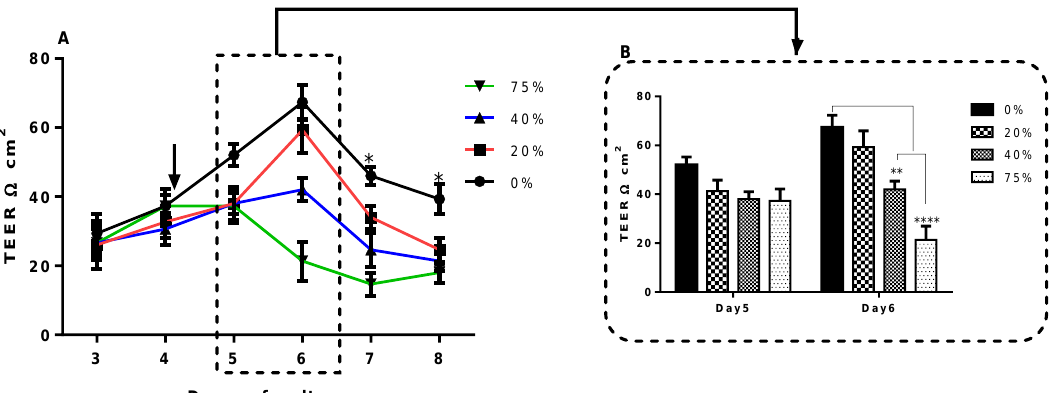
Figure 7. TEER of bEnd.3 cells exposed to selected concentrations of U-87CM. ( A ) TEER of bEnd.3 monolayer exposed to U-87CM produced from U-87 cells in normoxic conditions (21% O 2 ). The arrow indicates the start of monolayer treatment with U-87CM at the end of day 4. The asterisks (*) refer to the significant difference between controls (0%) and cells exposed to selected concentration of normoxic U-87CM; on day 7 (at 40% and 75%; * p < 0.05, *** p < 0.001, respectively); on day 8 (at 20% (* p < 0.05), at 40%, and 75% (*** p < 0.001)). ( B ) Compares “peak” TEER values across bEnd.3 monolayers on days 5 and 6 after exposure (for 24 and 48 h, respectively) to U-87CM from the normoxic conditions (* p < 0.05, *** p < 0.001), ( n = 3). Using the same experimental design as in the normoxia permeability experiments, hypoxic U-87CM also decreased the barrier resistance (Figure 8A). The difference in TEER across the control (0%) and the bEnd.3 monolayers exposed to U-87CM concentrations at day 5 (after 24 h exposure) was a nonstatistical decrease across the treatment concentration range (Figure 8B, day 5). However, 24 h later, on day 6, hypoxic U-87CM had a significant decrease in the barrier resistance in a concentration-dependent manner (Figure 8B) at 40% ( p < 0.01) and 75% ( p < 0.0001), respectively. However, the resistance of bEnd.3 monolayers exposed to 20% U-87CM at day 6 was not significant, in comparison to the control.